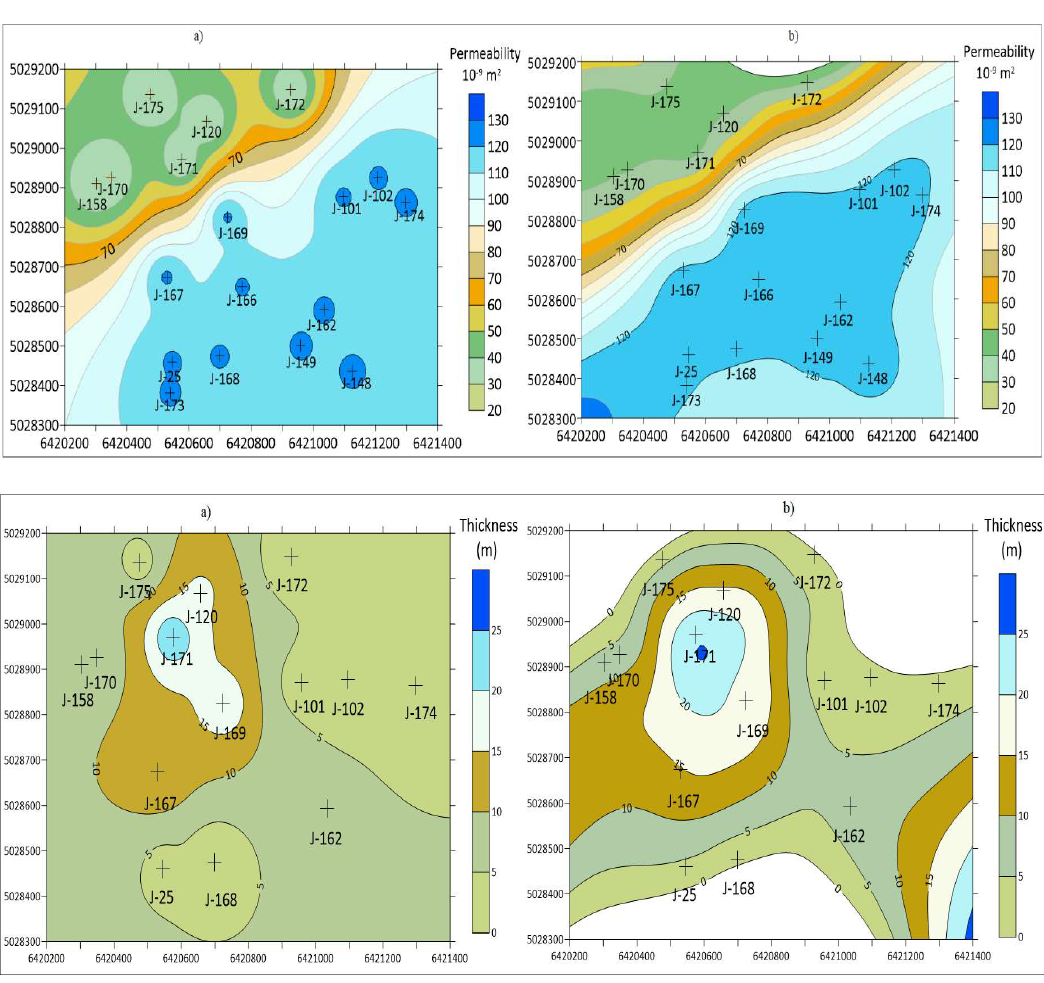
Figure 5. The mapping of the Lower Pontian “K” reservoir, the Sava Depression, Northern Croatia. Left—IDW results, right—MSM results. Top—porosity, middle permeability, down—thickness [43].